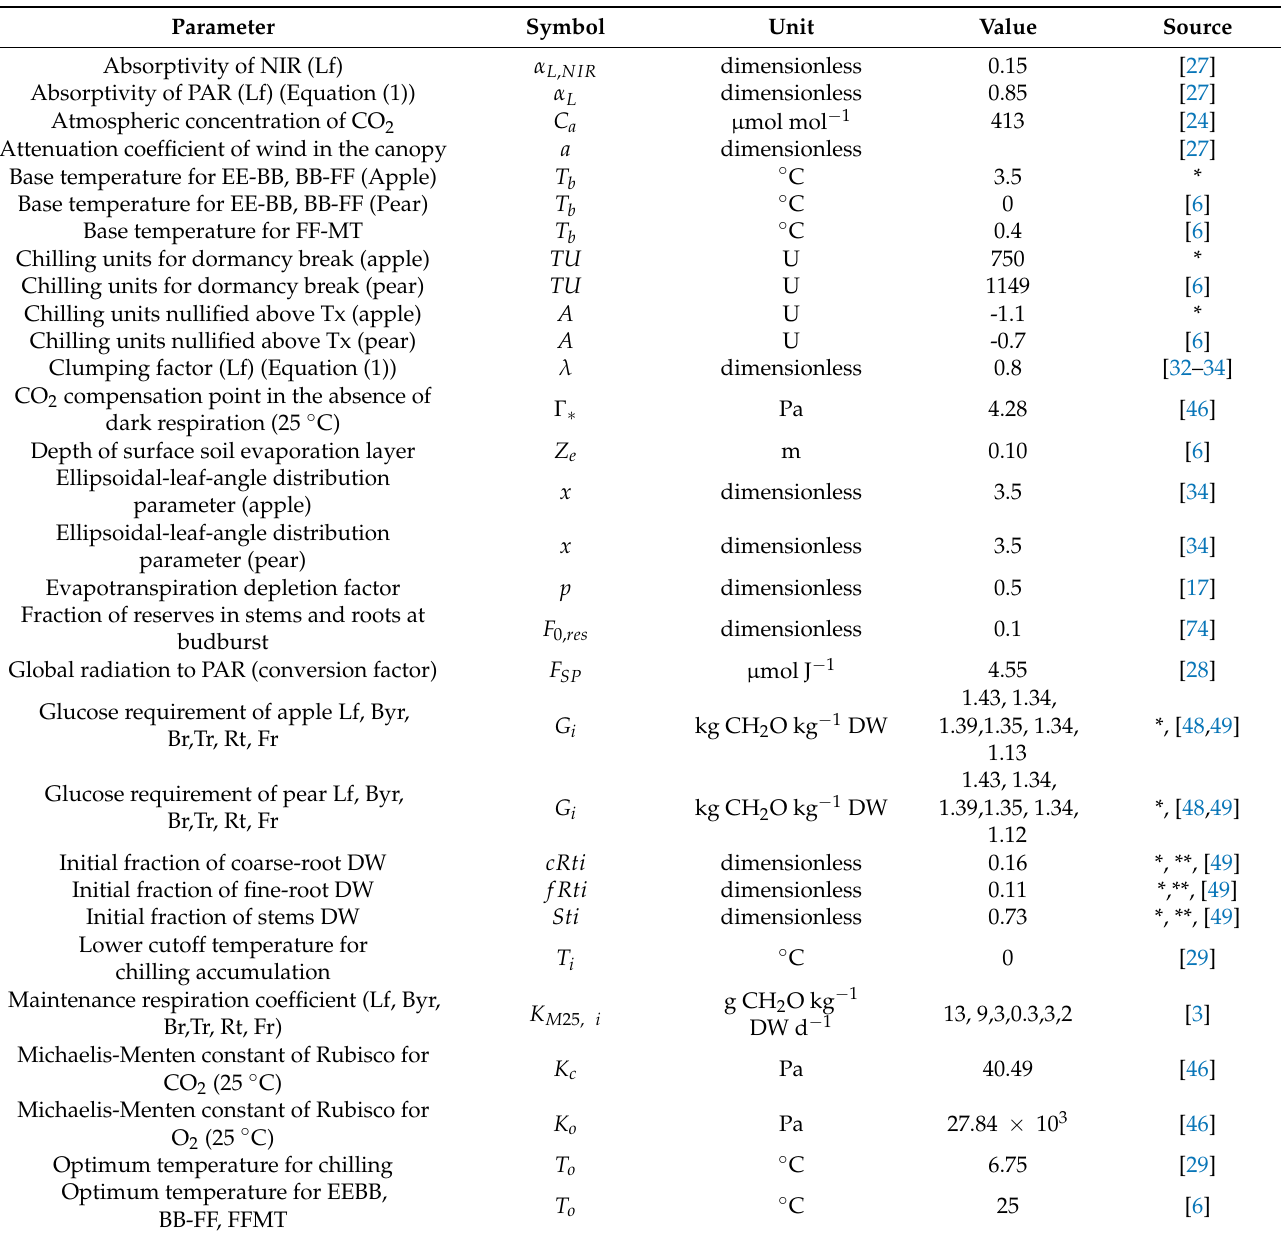
Table A1. List of the main parameters of CSS.Pome and their values. EE-BB = end of endodormancy to budbreak; BB-FF = budbreak to full flowering; FF-MT = full flowering to fruit maturity; Lf =